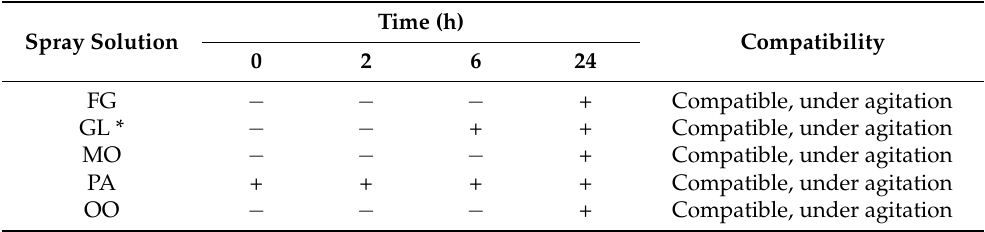
Table 1. Physical stability and compatibility of fungicide spray solutions at different observation times (0, 2, 6 and 24 h): fungicide only (FG), fungicide + glyphosate (GL), fungicide + mineral oil (MO), fungicide + propionic acid (PA), fungicide + orange oil (OO). Time (h) Spray Solution Compatibility 0 2 6 24 FG − − − + Compatible, under agitation GL * − − + + Compatible, under agitation MO − − − + Compatible, under agitation PA + + + + Compatible, under agitation OO − − − + Compatible, under